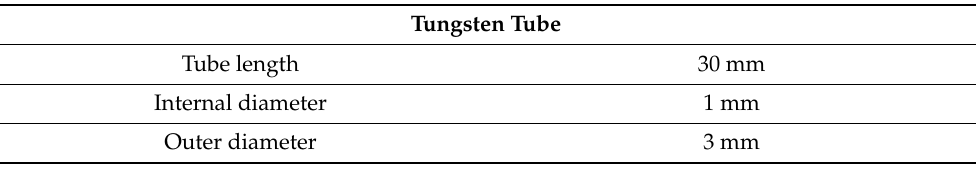
Table 2. Tungsten Tube parameters.